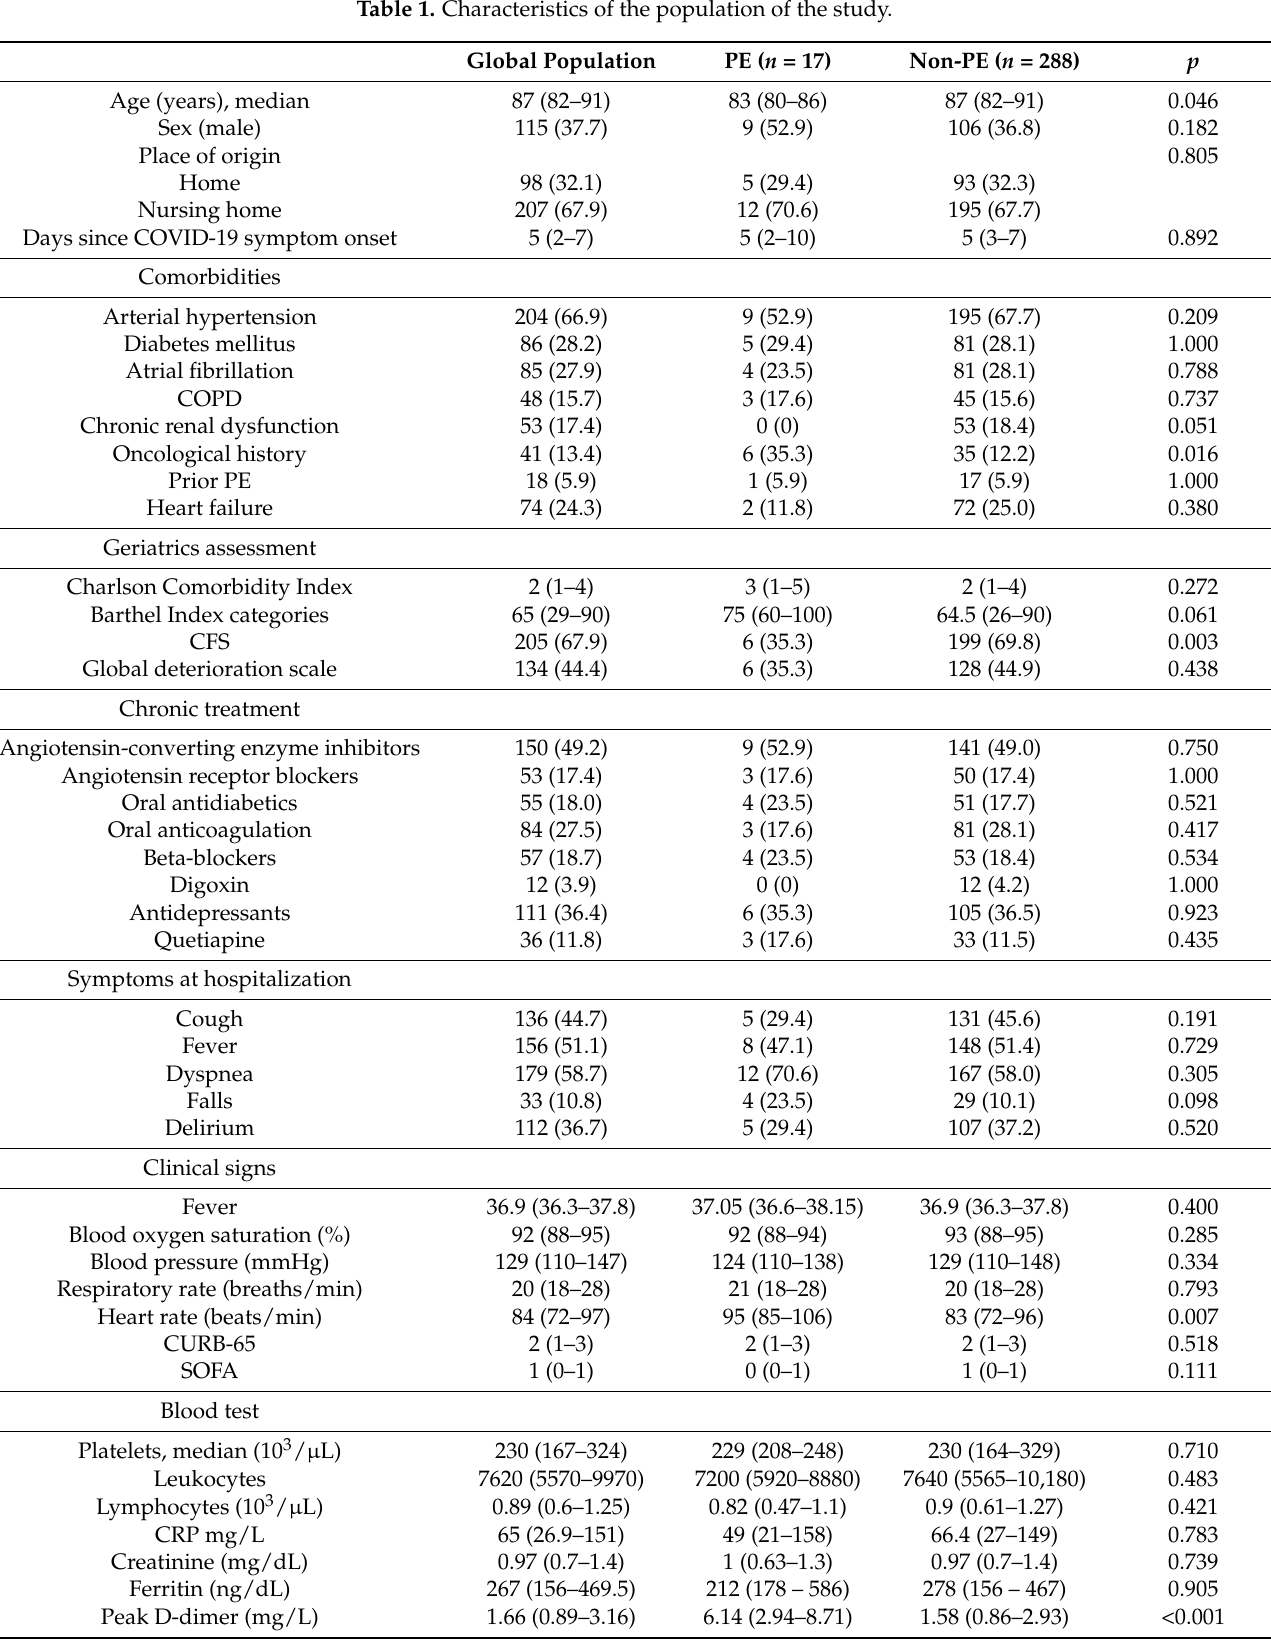
Table 1. Characteristics of the population of the